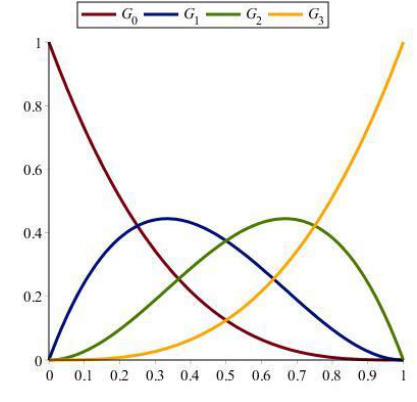
Figure 1. Bernstein polynomials of degree